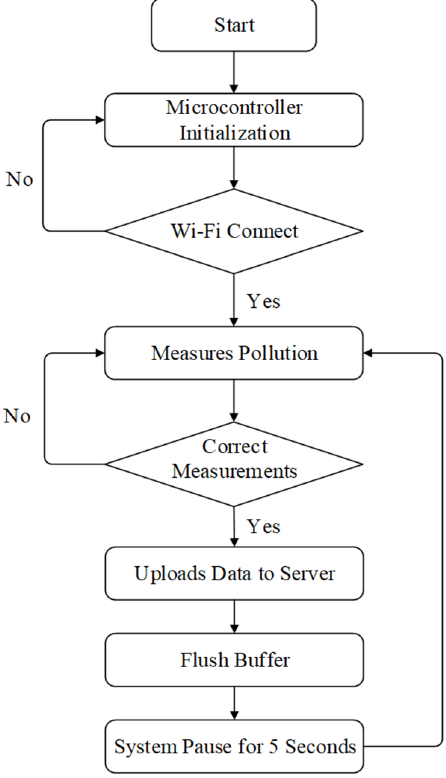
Figure 4. The process of environment sensing.